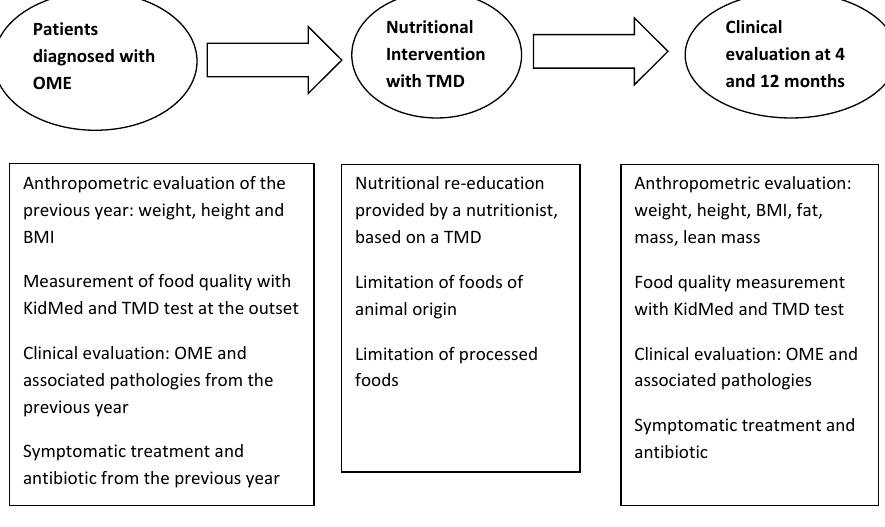
Figure 1. Study Design